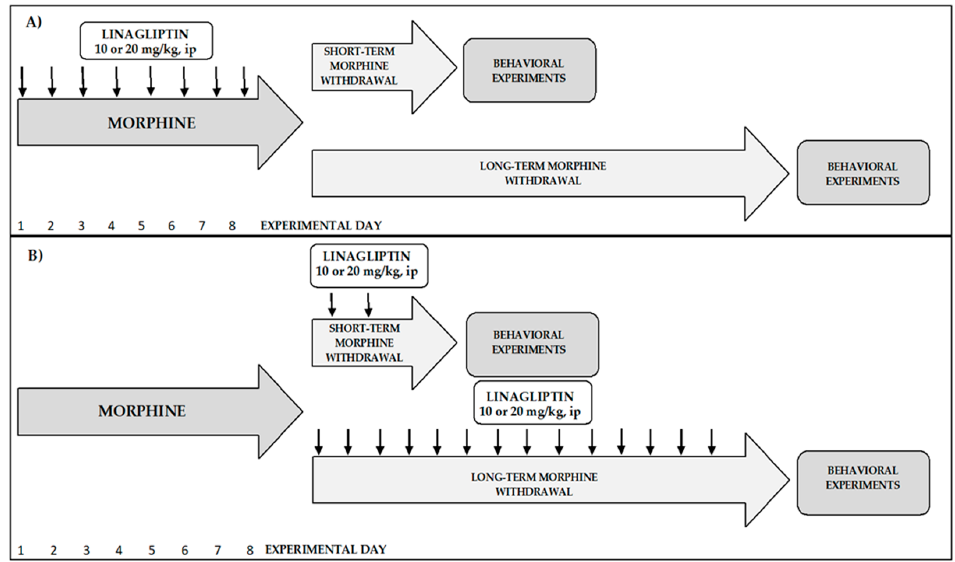
Figure 1. Graphical presentation of experimental procedures. The morphine dependence was obtained by administration of increasing doses (from 10 to 50 mg/kg, ip) of morphine twice a day for 8 consecutive days. Linagliptin (10 and 20 mg/kg, ip) was administered via two procedures: ( A ) linagliptin was administered simultaneously with morphine (8 injections); ( B ) linagliptin was administered during morphine withdrawal (2 or 14 injections). The effect of linagliptin was observed during short-term (60 h) and long-term (14 days) morphine withdrawal.